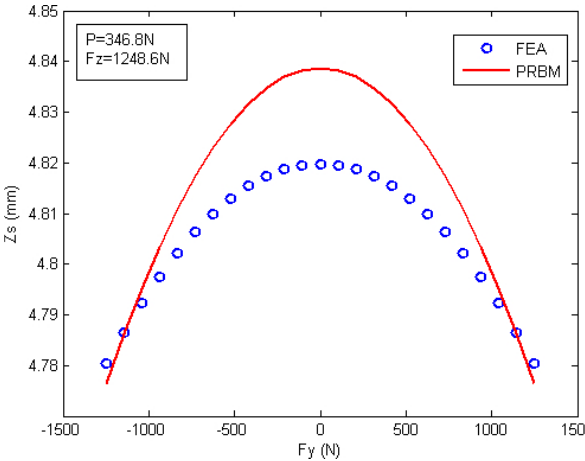
Figure 9. Primary translational displacement verification: cross- axis coupling e ff ect in the two primary translational